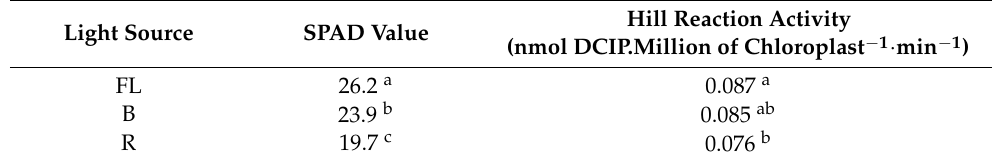
Table 2. SPAD value and Hill reaction activity of H. corymbosa leaves after 4 weeks of growth under different light sources at a 50 µ mol · m − 2 · s − 1 light intensity.